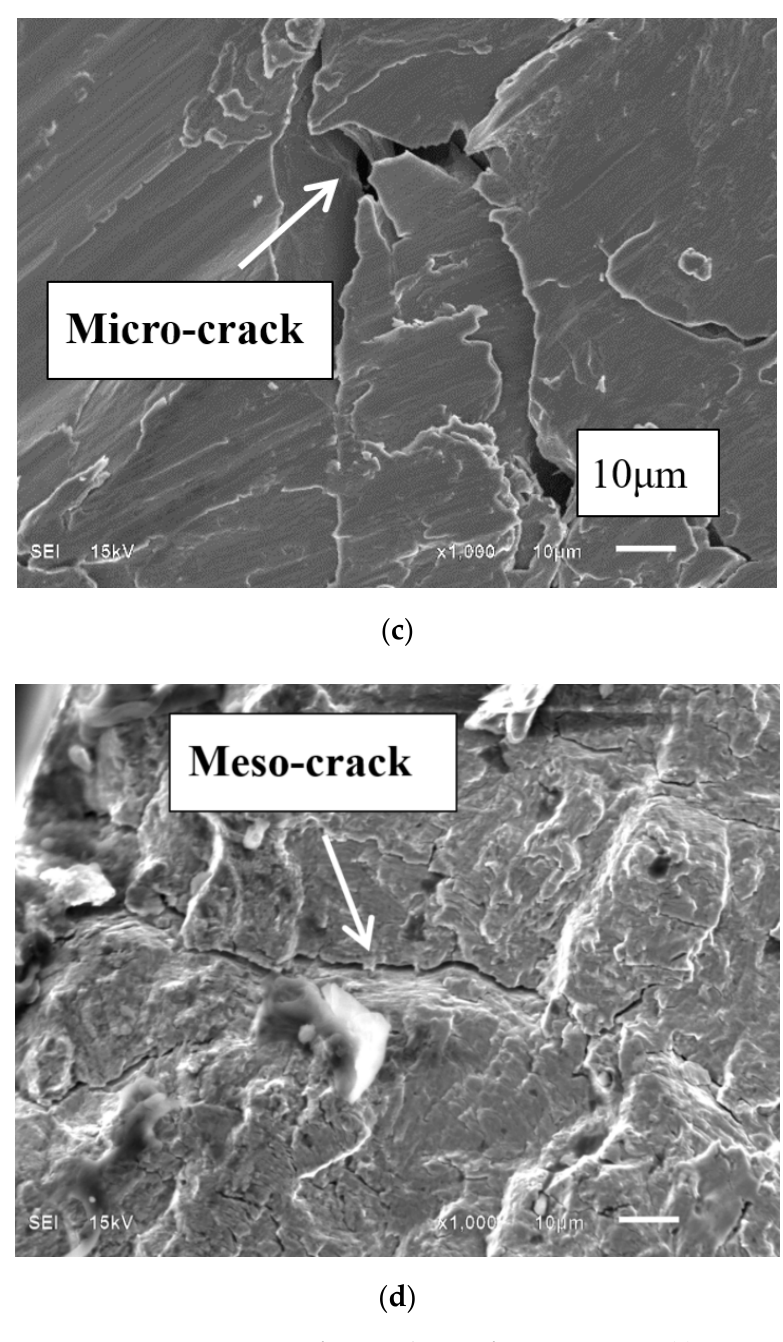
Figure 8. SEM microstructure of KMN vibration fatigue specimen. ( a ) Point A in Figure 7; ( b ) point B in Figure 7; ( c ) point C in Figure 7; ( d ) point D in Figure 7.